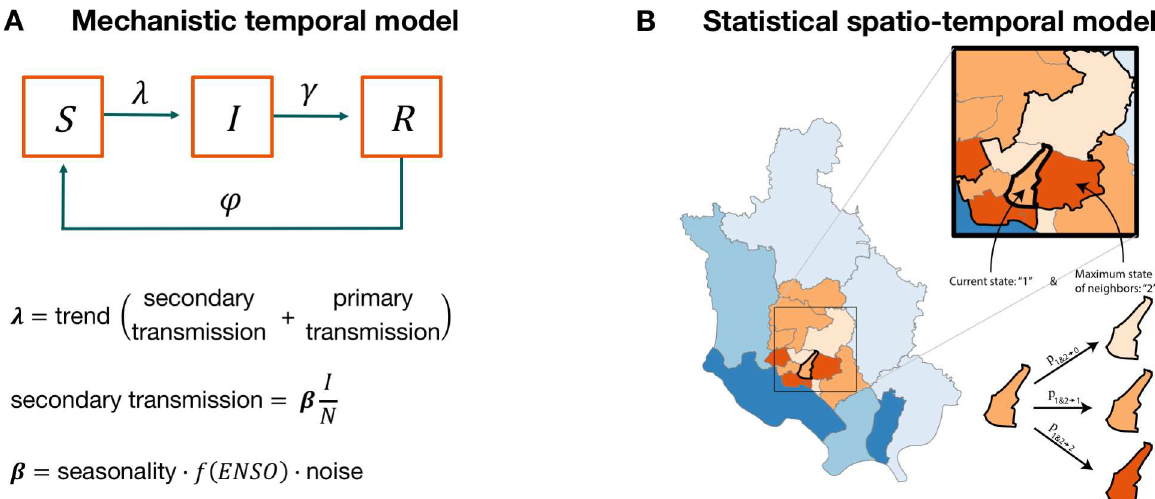
Fig 1. Schematic representation of the models. (A) Mechanistictemporalmodel. The populationis dividedinto three classes, for the susceptible S , infected I and recovered R individuals. The arrows denote rates of flow among these classes. The force of infection λ includesthree components:a long-termtrend, secondary transmissionthat dependson the levels of infectionin the population, and primary transmission at a constant rate from an environmental reservoir of the pathogen. The transmission coefficient (or rate) β in secondarytransmissionincorporates seasonality, interannualvariationas a function of the ENSO index, and environmental noise. (B) Statistical spatio-temporal model. Districts of the city known as “thanas” are groupedinto two main regions (depicted in orangefor the core and in blue for the periphery). Thanas within the same group follow the same dynamical rules in terms of transitionsbetween cholera levels or states from one month to the next. Three states are considered and used to discretizethe case data: no cholera (0), low cholera (1), or high cholera (2) as indicatedby the different color intensity. The probability of transition betweenstates from one month to the next depends on the season, the maximum state of neighboring districts, and the climate covariate (ENSO). For detailson the models, see Methods and S1